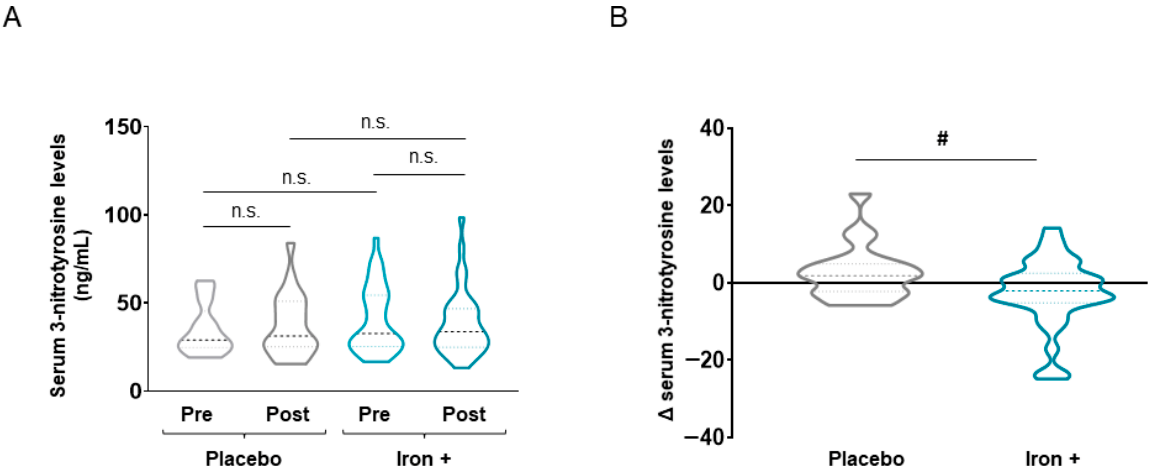
Figure 3. Violin plots of absolute 3-nitrotyrosine levels in serum of all COPD patient groups ( A ) and delta (post-pre) of serum 3-nitrotyrosine levels in placebo and iron-treated groups ( B ). The dashed line represents the median and the dotted lines the interquartile ranges. Statistical significance: n.s., no significance; # p < 0.05 between iron and placebo treatment.